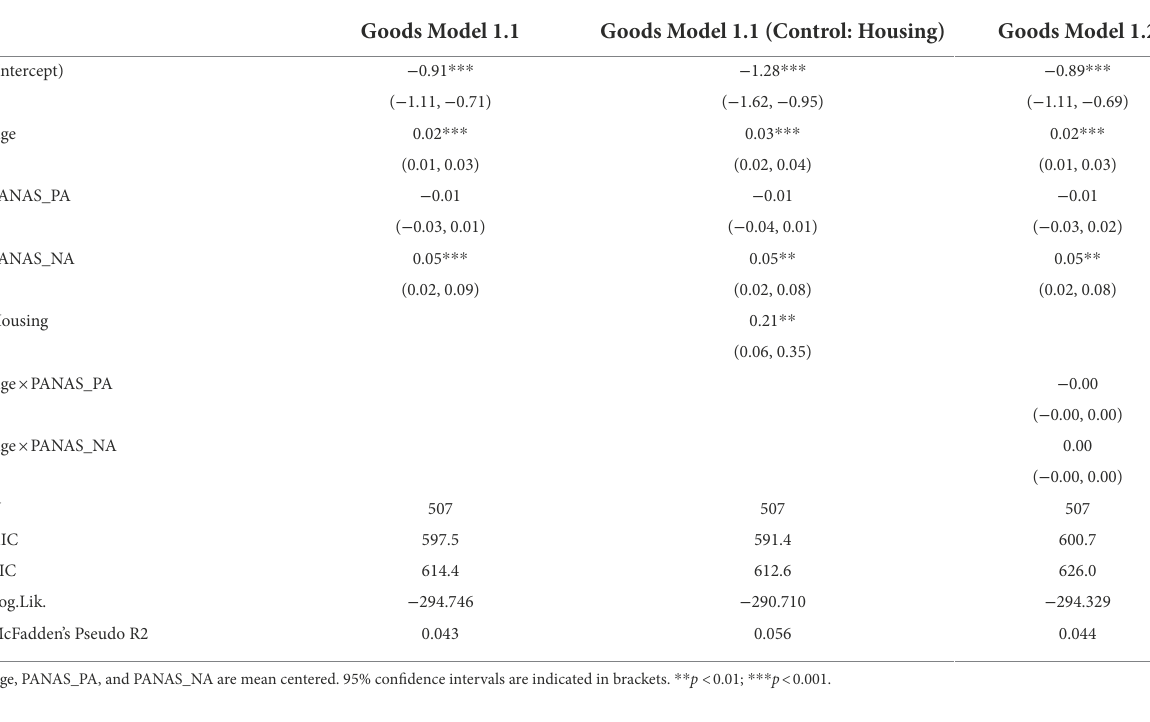
TABLE 4 Goods scarcity model.